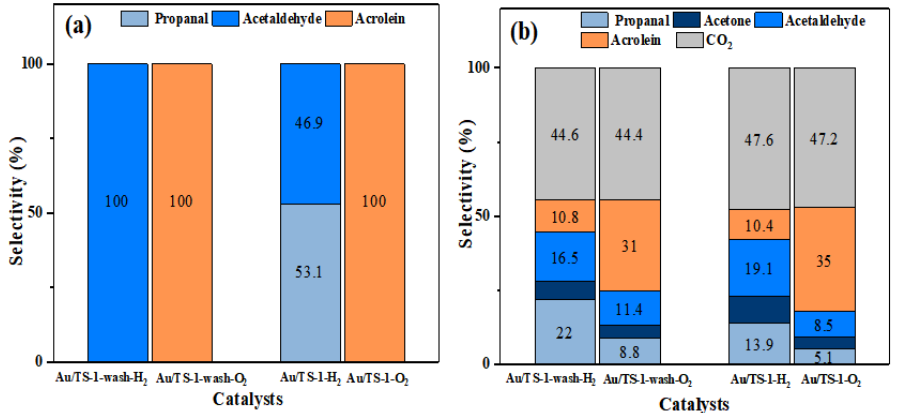
Figure 2. Catalytic results over Au/TS-1 with no-hydrogen feed gas. The reaction temperatures are: ( a ) 150 °C ( b ) 200 °C.